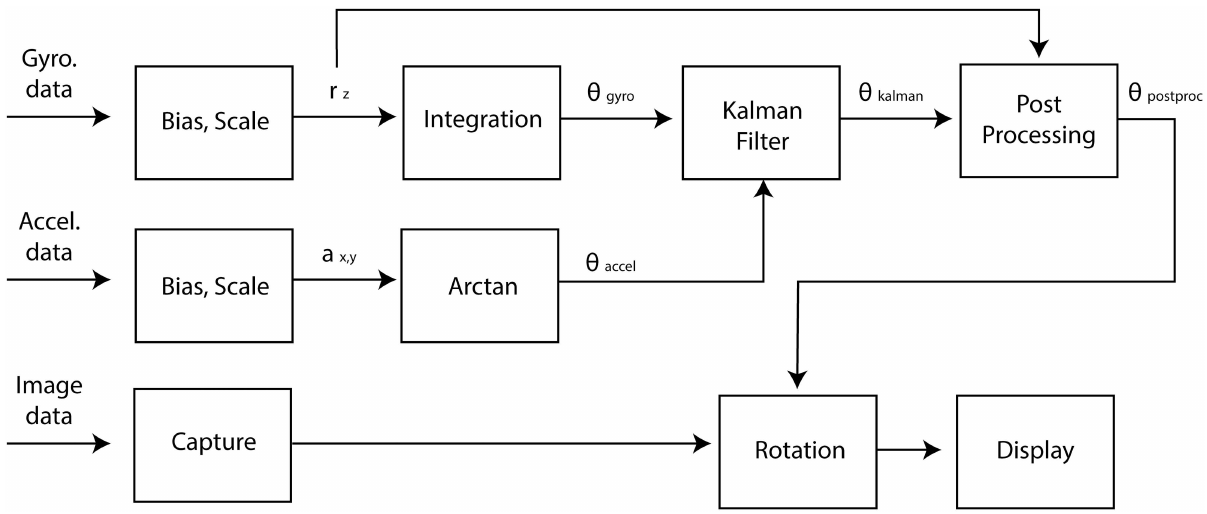
Fig 2. Schematic diagram of the image orientation correction system. r z is the angularvelocity measuredby the gyrosensor; a x , y is the accelerationmeasuredby the accelerometer; θ gyro and θ accel are the rotationalanglescalculatedfrom the gyrosensorand accelerometer data, respectively; θ Kalman is the rotationalangle after the Kalman filter; and θ postproc is the final rotationalangle used for image rotation. Gyro., gyrosensor; Accel., accelerometer.